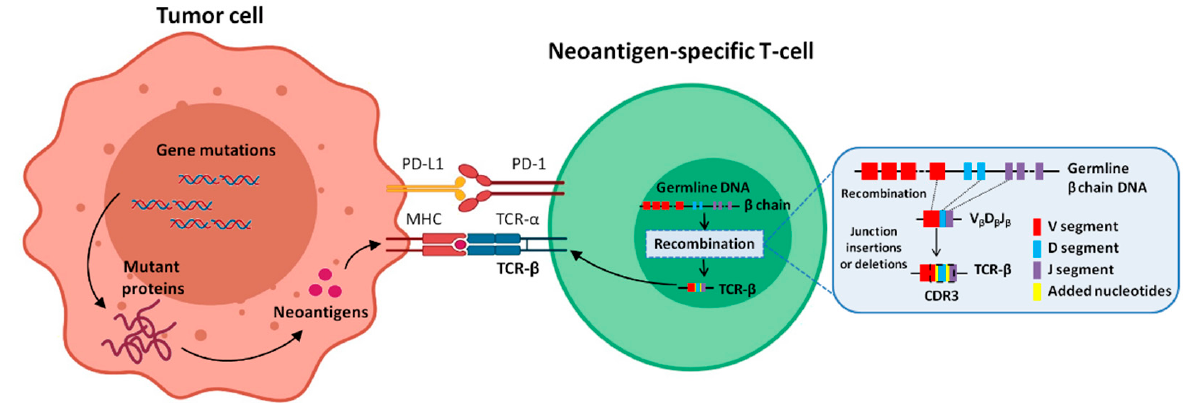
Figure 1. Relationship between tumor cell and neoantigen-specific T-cell. On one hand, tumor cells with high tumor mutational burden (TMB) produce an elevated neoantigen load. The neoantigens are processed within the tumor cell, presented by the major histocompatibility complex (MHC) molecule, and recognized by a neoantigen-specific T cell receptor (TCR). On the other hand, the TCR is represented on the T cell surface, consisting of a heterodimeric protein comprising two chains: α (TCR- α ) and β (TCR- β ). The highly variable complementarity determining region 3 (CDR3) of TCR- β is encoded at the gene level, in the variable (V), diversity (D), and joining (J) segments. During somatic diversification, one of each segment is randomly combined, and further diversity is introduced through insertions and/or deletions of added nucleotides. CDR3 is the main region responsible for recognizing processed antigens.